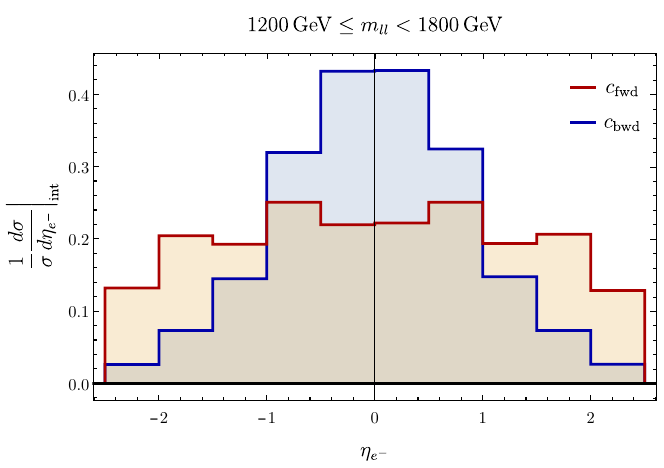
Figure 1 . Normalized interference cross-sections at the LHC differential in the pseudorapidity η of the electron. The red spectrum shows the contribution generated by the operators of the combination c in eq. (2.5), while the blue spectrum shows the contribution from c fwd